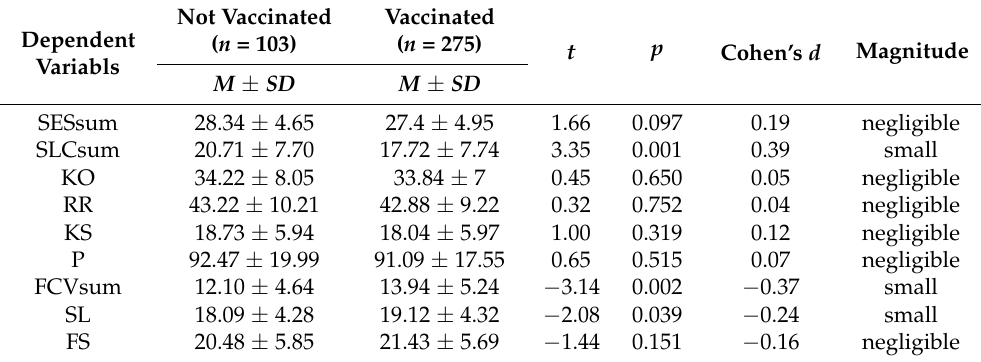
Table 3. Differences in all subscales in regard to vaccination